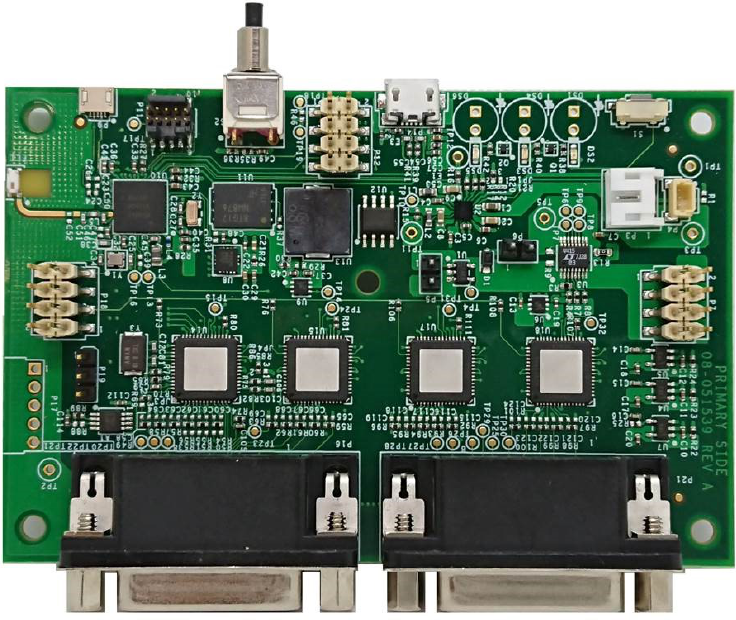
Figure 1. ADAS1000 based board for high quality ECG signal